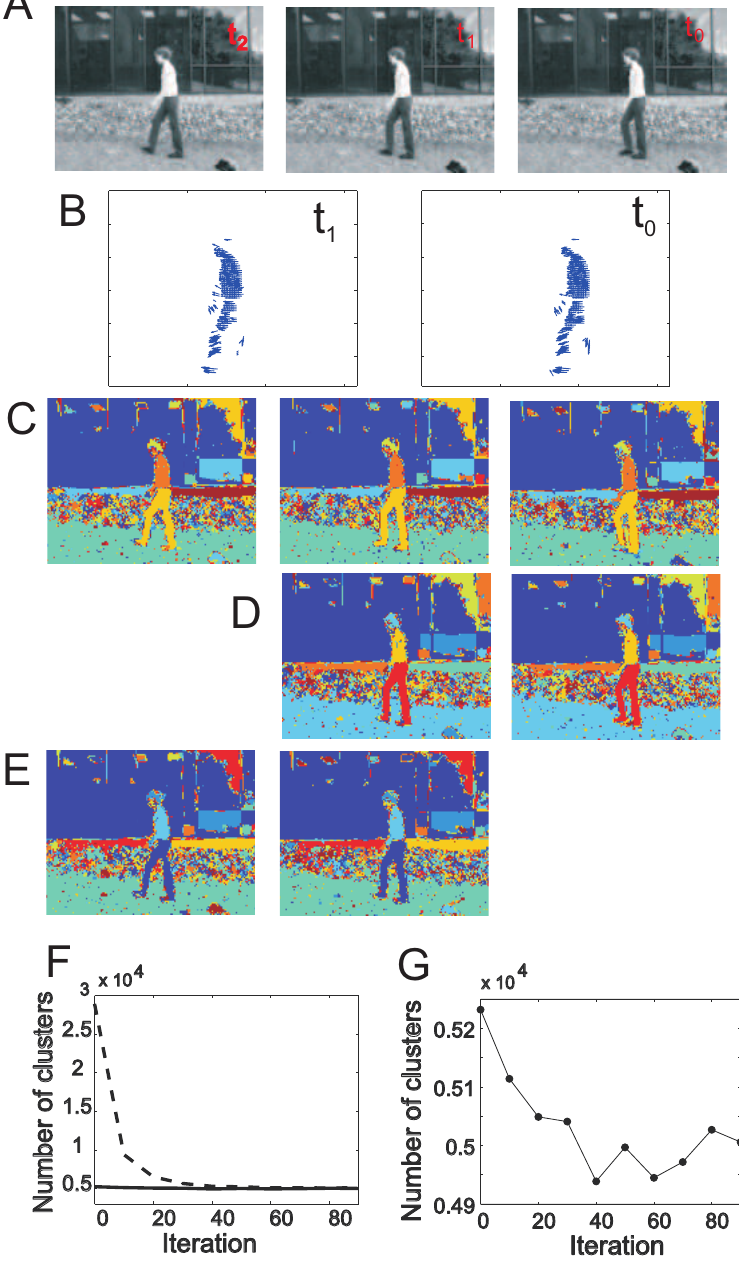
, t , and t , respectively. B 0 1 2 to t , and t to t . C Spin states after 0 1 1 2 and t . E Spin states for 0 1 and t . F The number of clusters as a function of the iteration 1 2 and t (dashed line) and for the second 0 1 and t (solid line). G Enlarged plot of the second 1 2